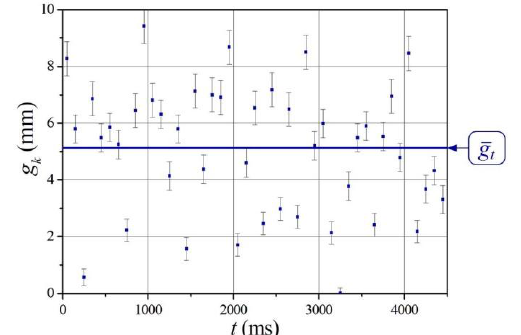
Fig. 8. The distribution of the average values of the depths of bubble clusters g k